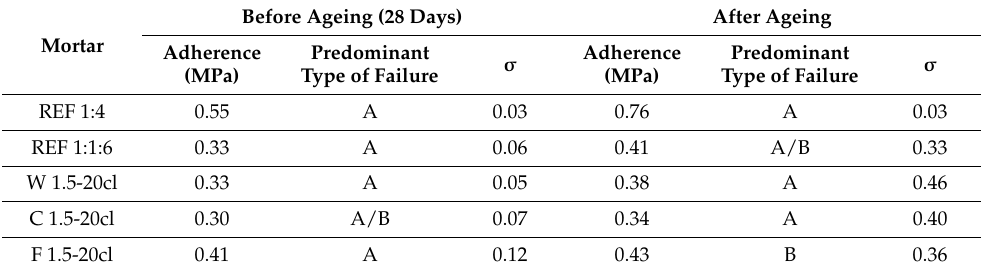
Table 5. Adherence resistance